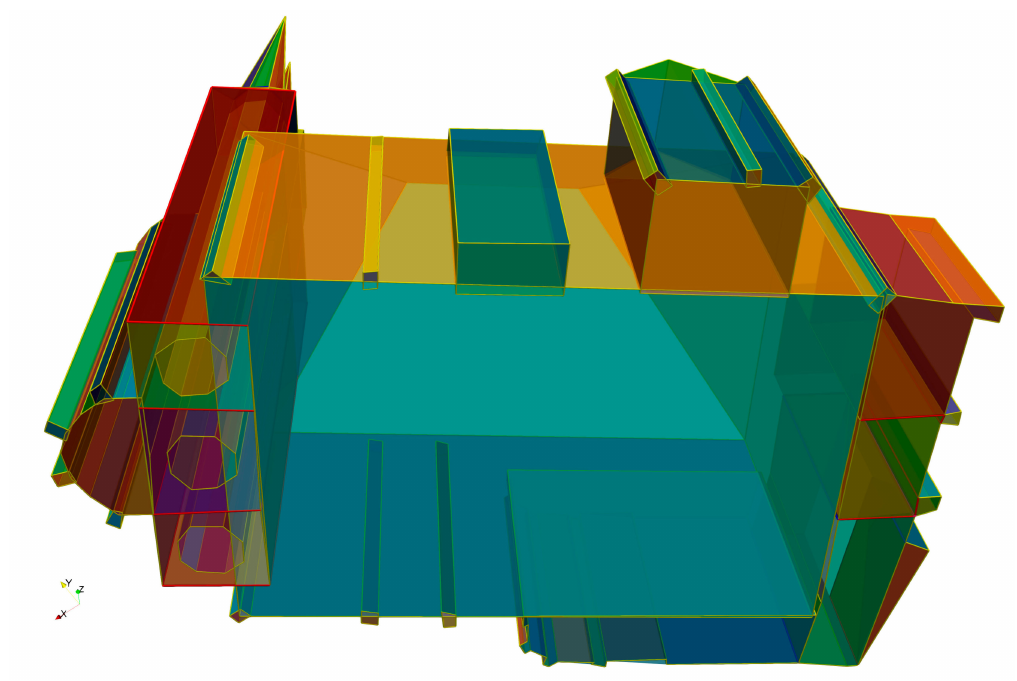
Figure 4. Example of non-consistent CityGML